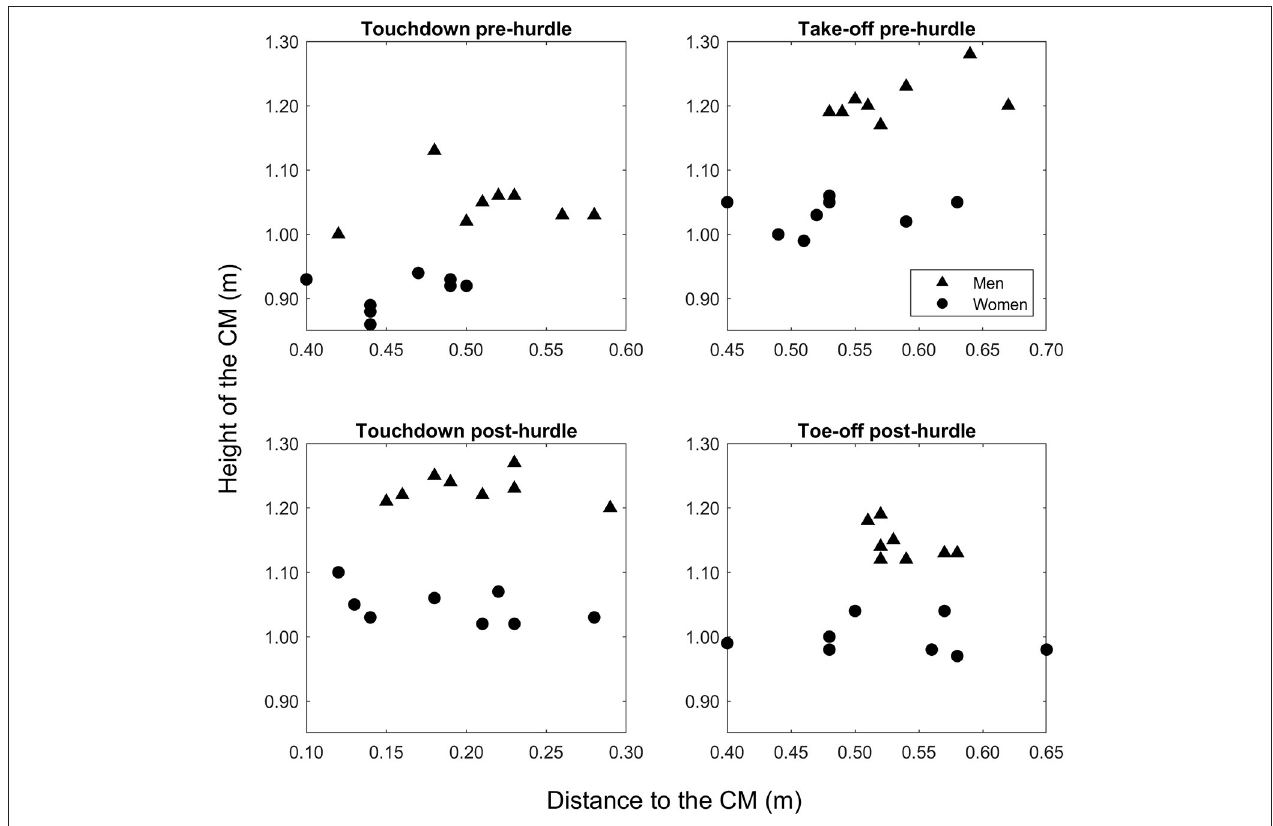
FIGURE 2 | Absolute values for the height of the CM for each man and woman at touchdown and toe-off in the stance phases pre- and